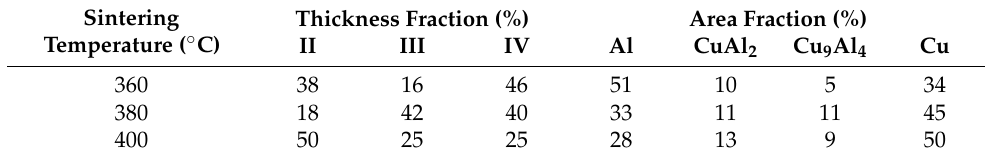
Table 1. Interdiffusion layer thickness fraction and area fraction of Al, CuAl2, Cu9Al4 and Cu.